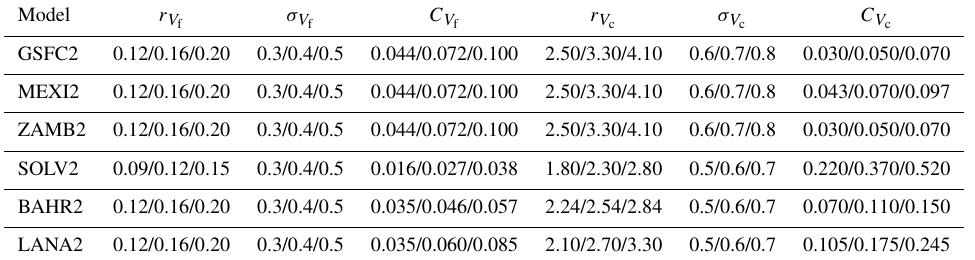
, C V [µm 3 µm − 2 c f